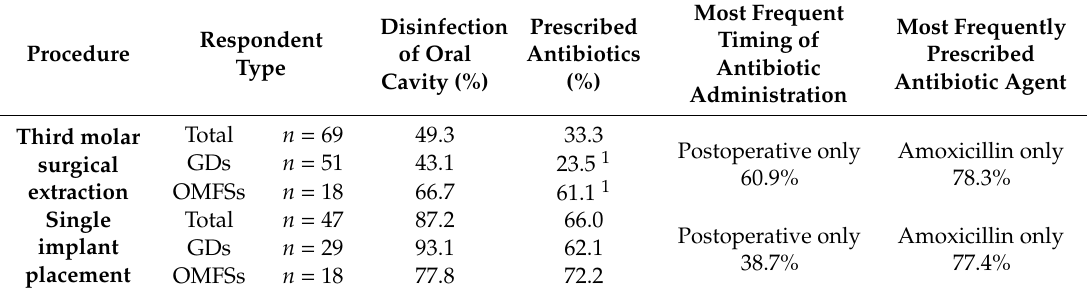
Table 2. Surgical procedures for which practitioners prescribe therapeutic antibiotics and the antibiotics agents used for patients with no relevant medical history and no allergy to penicillin.